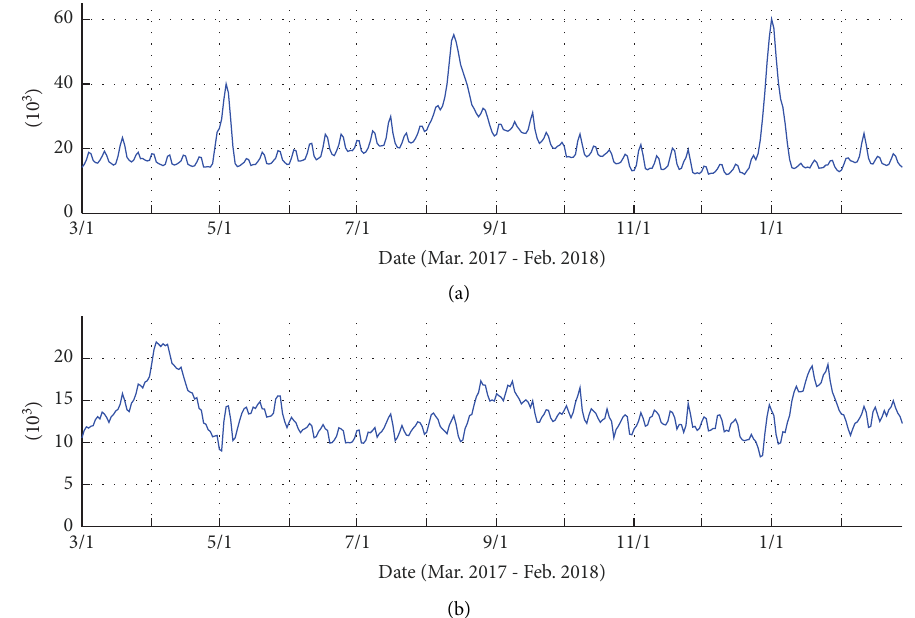
Figure 2: Day-to-day dynamics of the number of travelers for 2OD pairs. (a) (Residence zone and destination zone) � (Tokyo, Hokkaido). (b) (Residence zone and destination zone) � (Fukuoka,